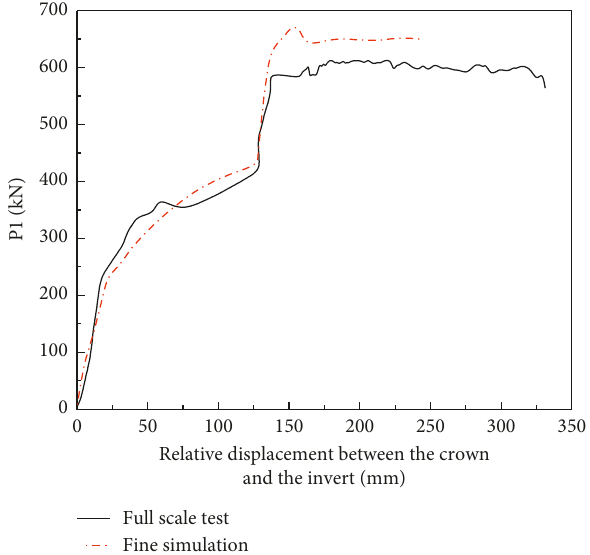
Figure 9: Comparison of load-displacement curves between the numerical analysis and the experiment.